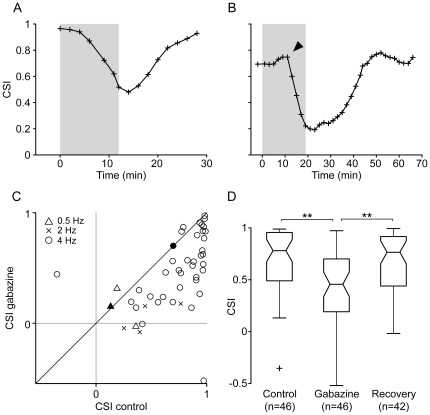
Effect of gabazine on the SSA index.(A, B) Examples of the evolution of CSI during the experiment. The shaded background indicates the application of gabazine, which starts at T = 0. In this and similar figures, the symbols indicate the time at the end of a testing sequence, so all times at or before 0 represent recordings completed before the start of the injection. The neuron shown in (4A) is the same one shown in Fig. 2A–C. The arrowhead in (B) indicates a transient increase in CSI observed in some neurons, probably due to the different time courses with which gabazine affected responses to standards and deviants. (C) In the population of neurons, only 4 showed an increased CSI during the application of gabazine (symbols on the left of the diagonal). The different symbols indicate the repetition rate at which stimuli were presented. The open symbols indicate cases in which there was a significant effect of gabazine (Bootstrapping, 95% c.i.), while the filled symbols indicate cases in which there was no significant effect. (D) Box plot of the CSI values for the population of neurons before, during and after the application of gabazine. The asterisks indicate significant differences (Friedman test, p<0.01).